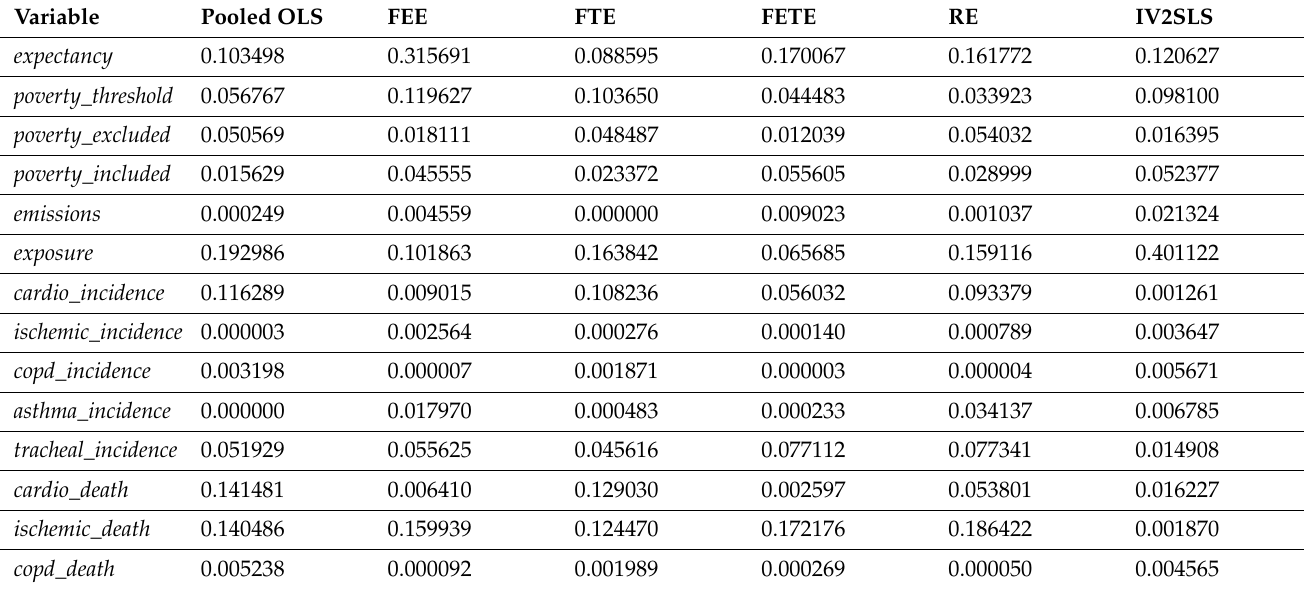
Table 4. Emulated feature importances for all linear